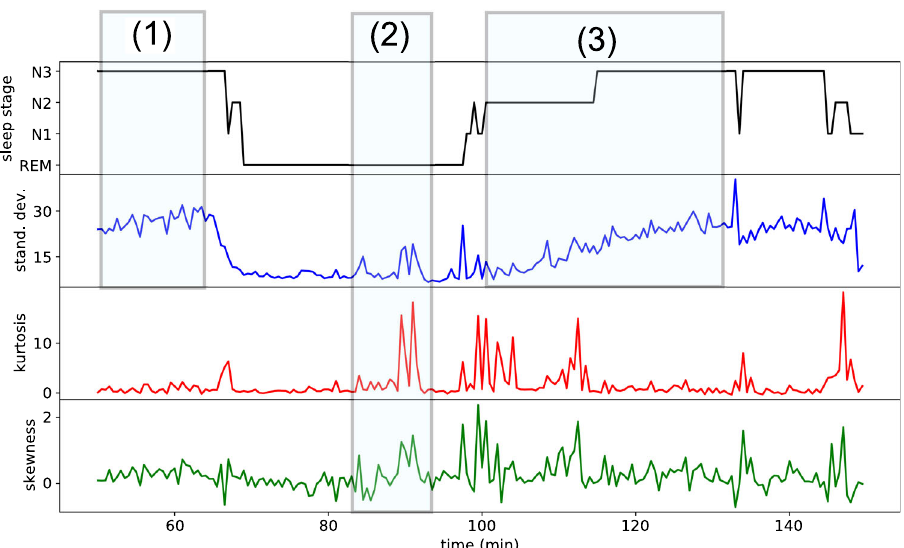
Fig. 4 Temporal evolution of hyper-parameters and trend analysis. Typical features in the temporal behavior of hyper-parameters, such as consistent trends (1) and extreme fl uctuations (2) within an ongoing sleep stage, as well as trends that extend across sleep stages (3).